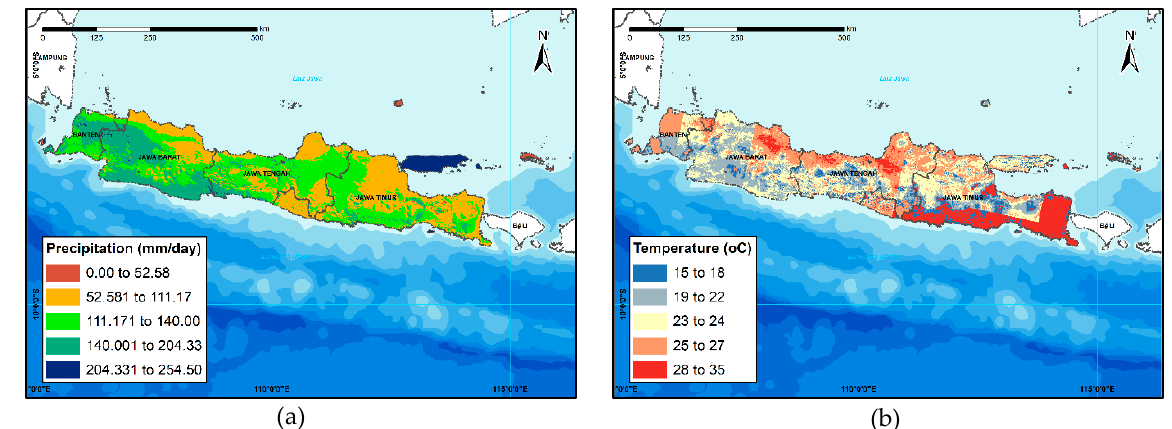
Figure 3. The climate parameters: rainfall/precipitation ( a ) and temperature ( b ).